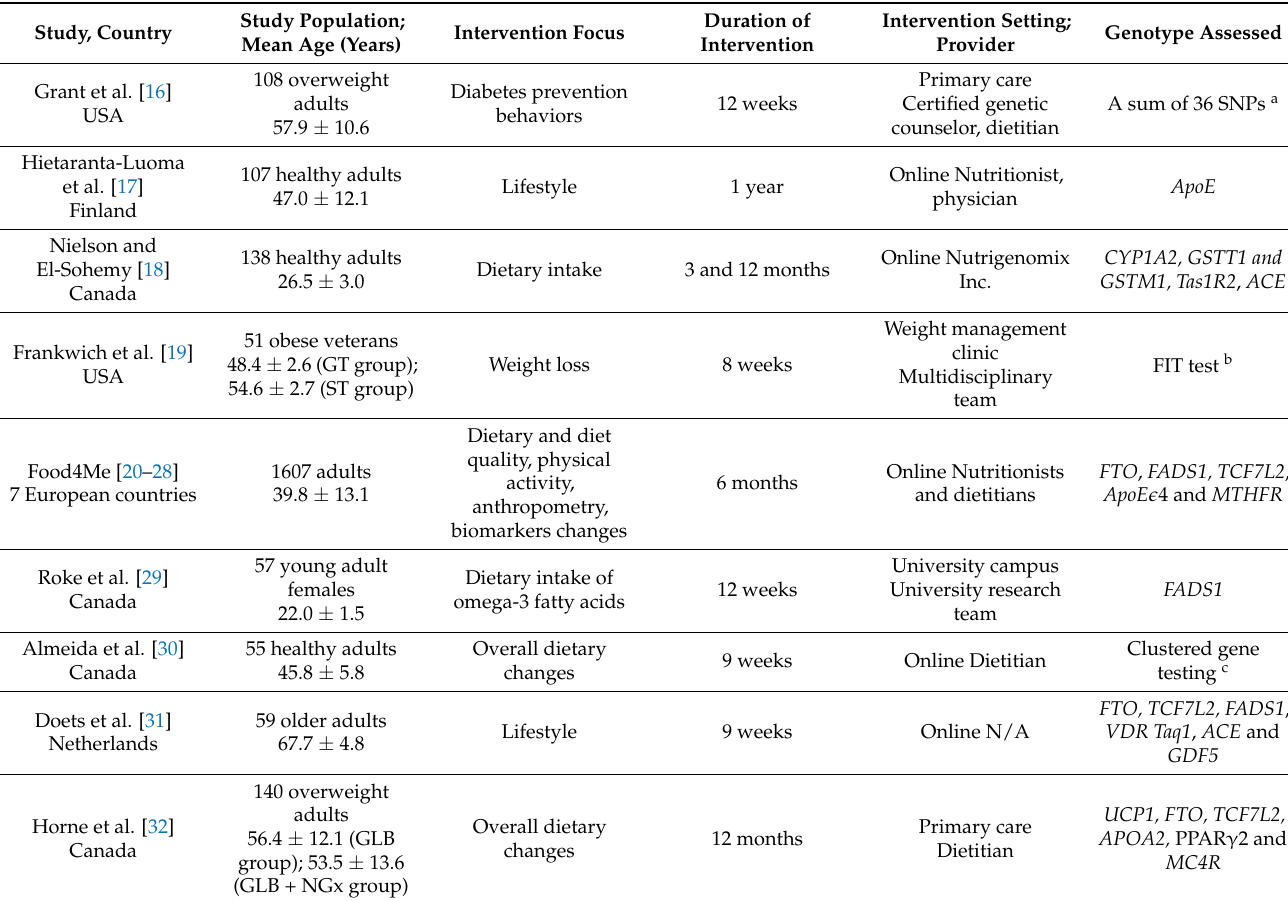
Table 1. Summary characteristics of the included studies (N =